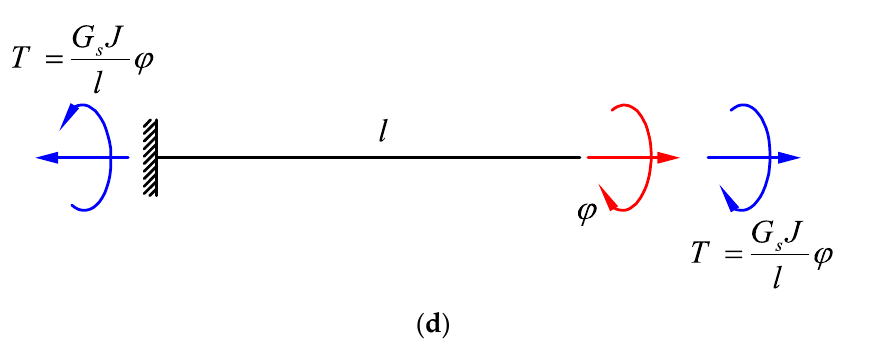
Figure 2. Forces and moments required to cause ( a ) lateral displacement, 𝛿, with no rotation at the free end of the beam, ( b ) rotation, 𝜃, with no lateral displacement at the free end of the beam, ( c ) pure axial extension, and ( d ) pure twist in the free end of an Euler–Bernoulli beam [32,36].